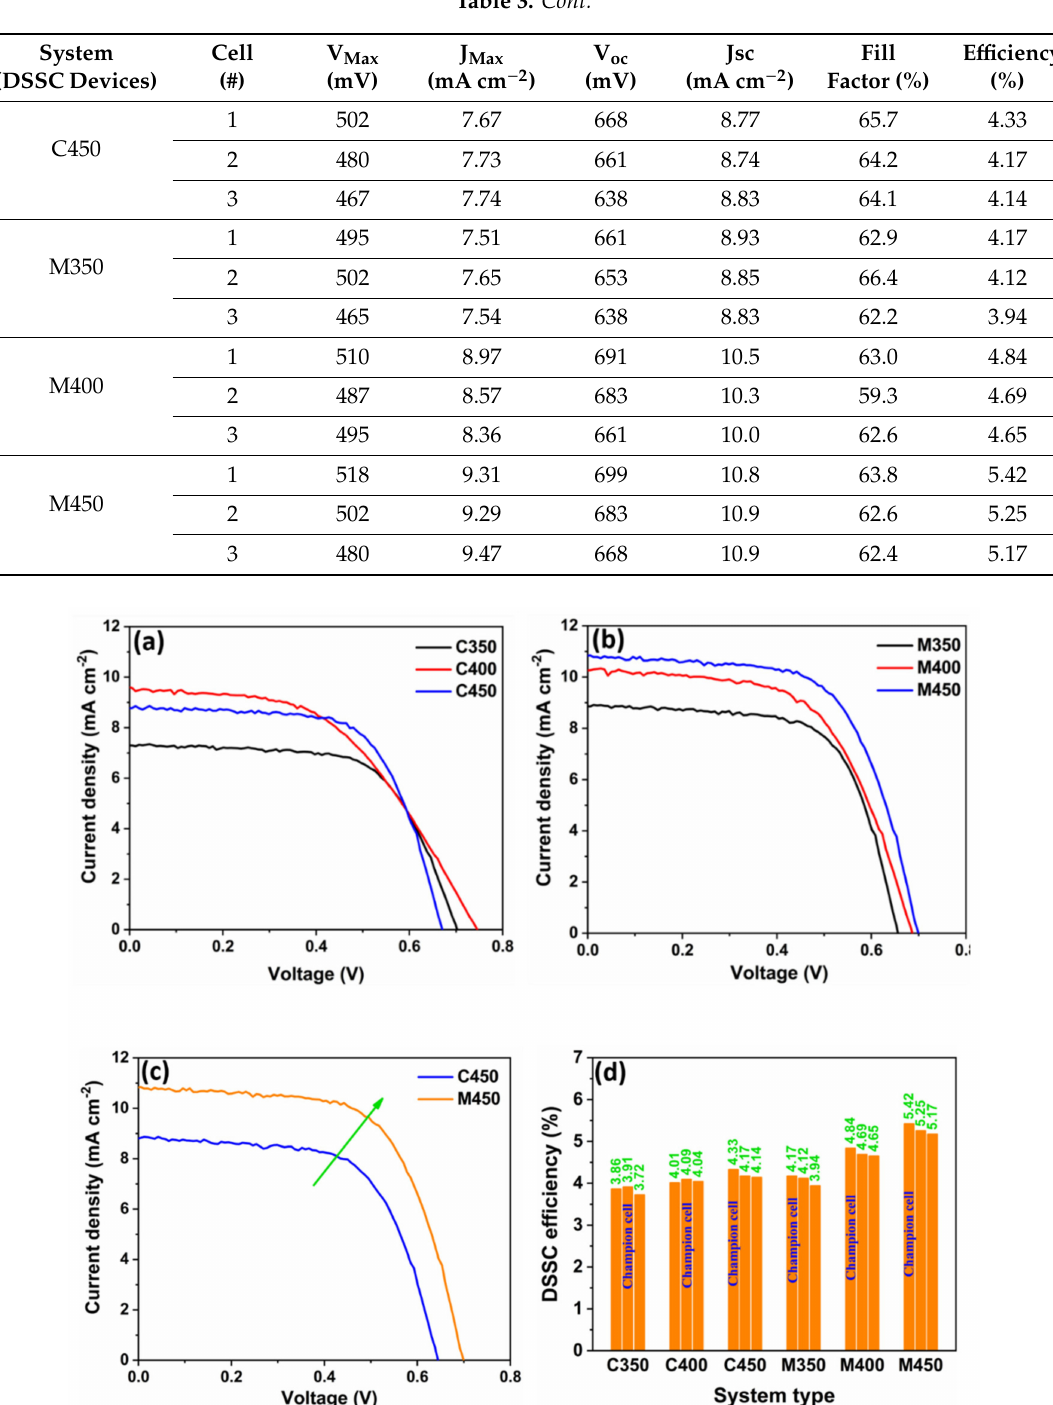
Figure 9. J-V curves of ( a ) Conventionally sintered titania-based DSSCs, ( b ) Microwave sintered titania-based DSSCs, ( c ) Comparison of J-V characteristics of DSSCs fabricated by conventional and microwave sintering of titania, ( d ) Graphical representation of the overall